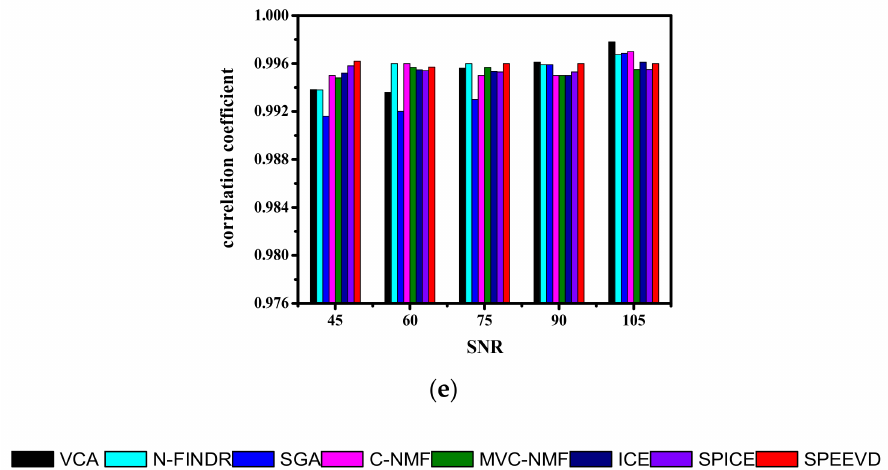
Figure 6. Correlation coefficients with different SNR levels. ( a ) Carnallite ( b ) Chlorite ( c ) Clinochlore ( d ) Clintonite ( e ) Corundum.